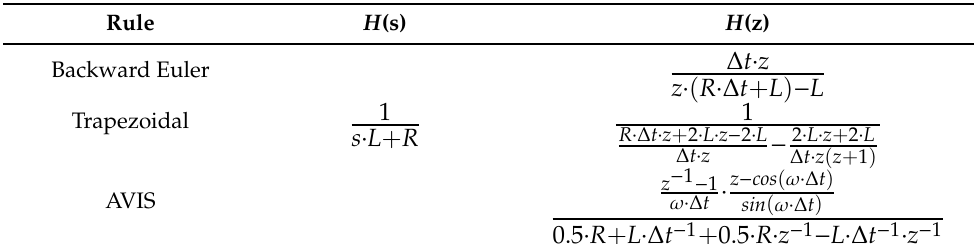
Table 1. Operator transmittances of the analyzed electrical